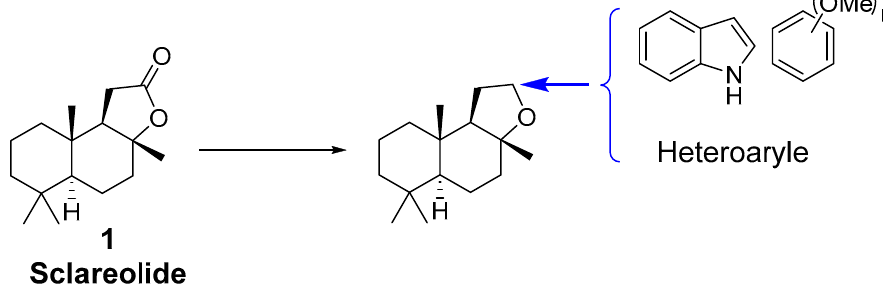
Figure 1. Design of sclareolide-indole conjugates and